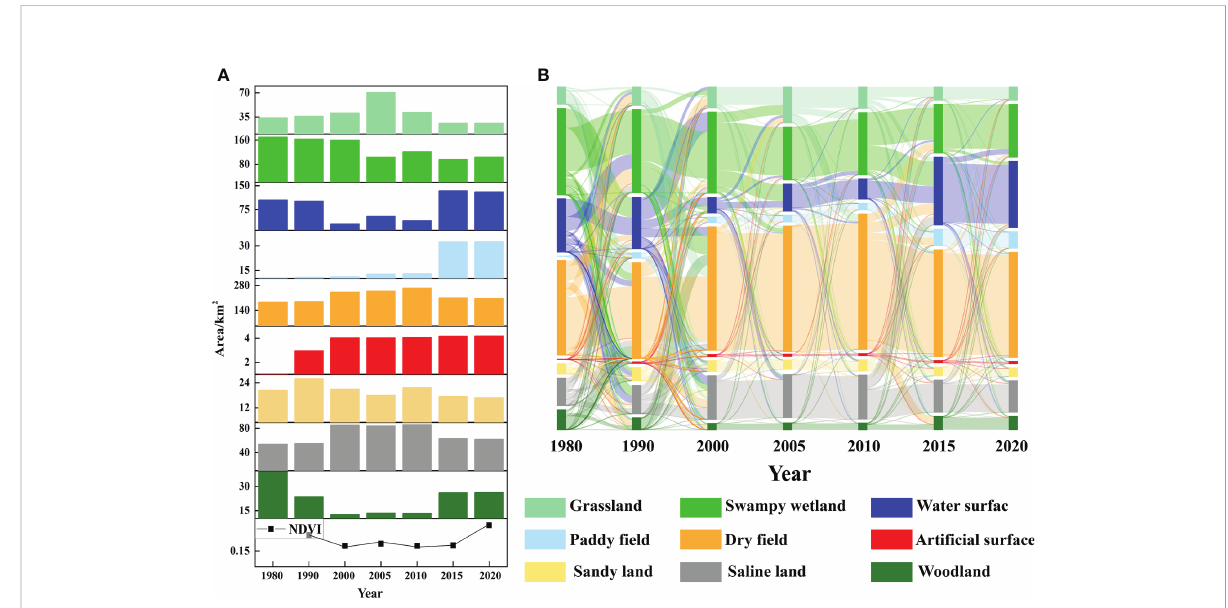
FIGURE 8 The change of land use types and NDVI values in the study area ( A is the trends in land use area and NDVI values, B is the sankey diagram of landscape transfer